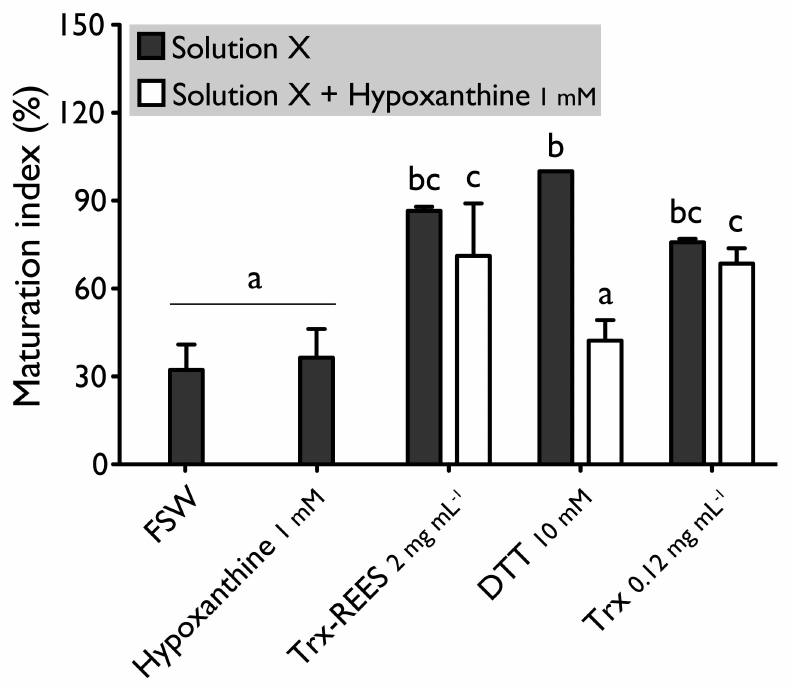
Figure 4. Effect of hypoxanthine (1 mM), on H. tubulosa oocyte maturation, induced by Trx-REES (2 mg mL − 1 ), DTT (10 mM) or thioredoxin from E. coli (Trx, 0.12 mg mL − 1 ). Values are means of maturation index ± SD ( n = 3 individuals). Means sharing at least one letter are not significantly different (T Tukey ≥ 0.05).